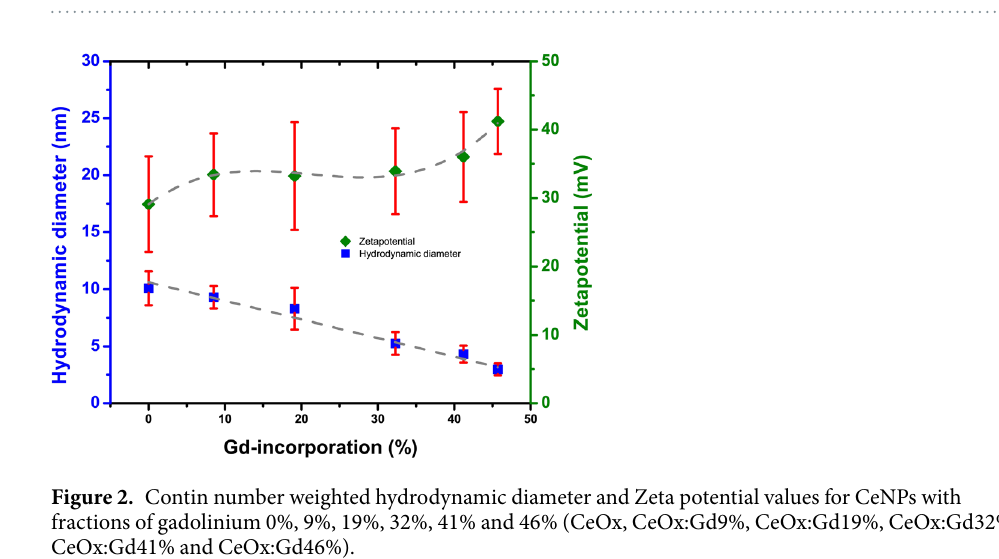
Figure 1. Top: schematic illustration of a gadolinium-integrated cerium oxide nanoparticle possessing antioxidant and MRI contrast enhancing properties. Bottom: results from (left to right) antioxidant assay, HRTEM and relaxivity measurement.